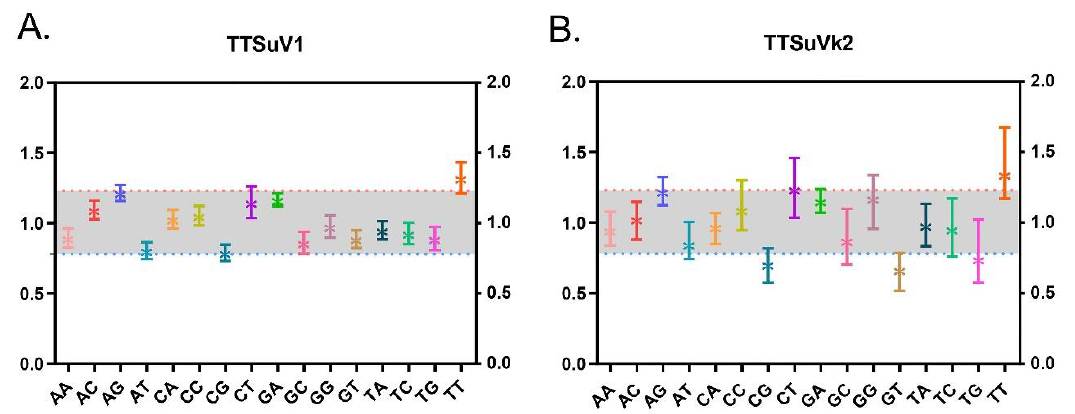
Figure 6. The 16 dinucleotide abundance of TTSuV1 ( A ) and TTSuVk2 ( B ). The pink dashed line represents the value 1.23, and the blue dashed line represents the value 0.78.